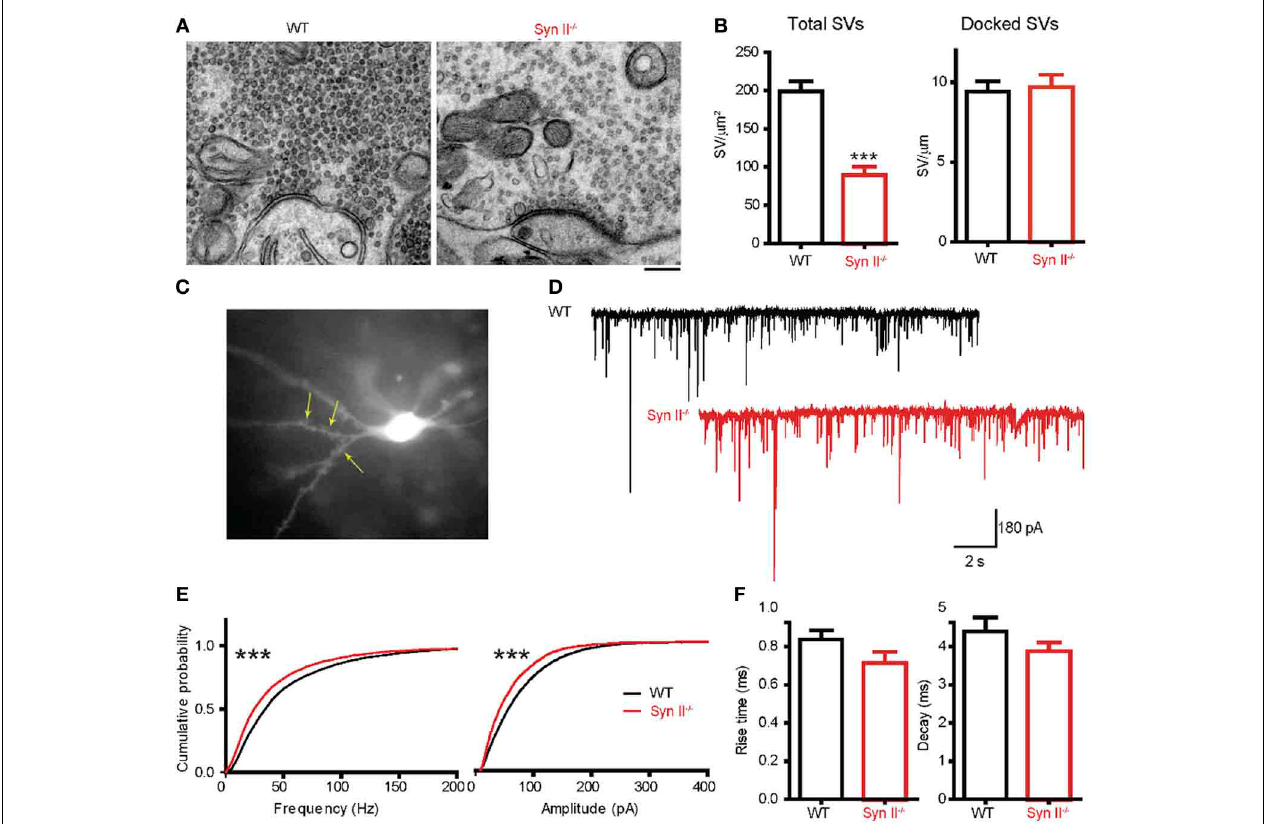
FIGURE 4 | A decreased number of mossy fiber synaptic vesicles is associated with reduced mEPSC frequency and amplitude in mossy cells from pre-symptomatic Syn II − / − mice. (A) Transmission electron microscopy images of mossy fiber terminals in the DG hilus of brain slices from WT (black bars) and pre-symptomatic Syn II − / − (red bars) mice (scale bar 200nm). (B) Mean ( ± s.e.m.) density of total SVs and number of docked SVs in presynaptic terminals of WT and Syn II − / − neurons; ∗∗∗ p < 0 . 001, two-tailed unpaired Student’s t -test. (C) Representative Syn II − / − hilar mossy cell patch-clamped in an acute